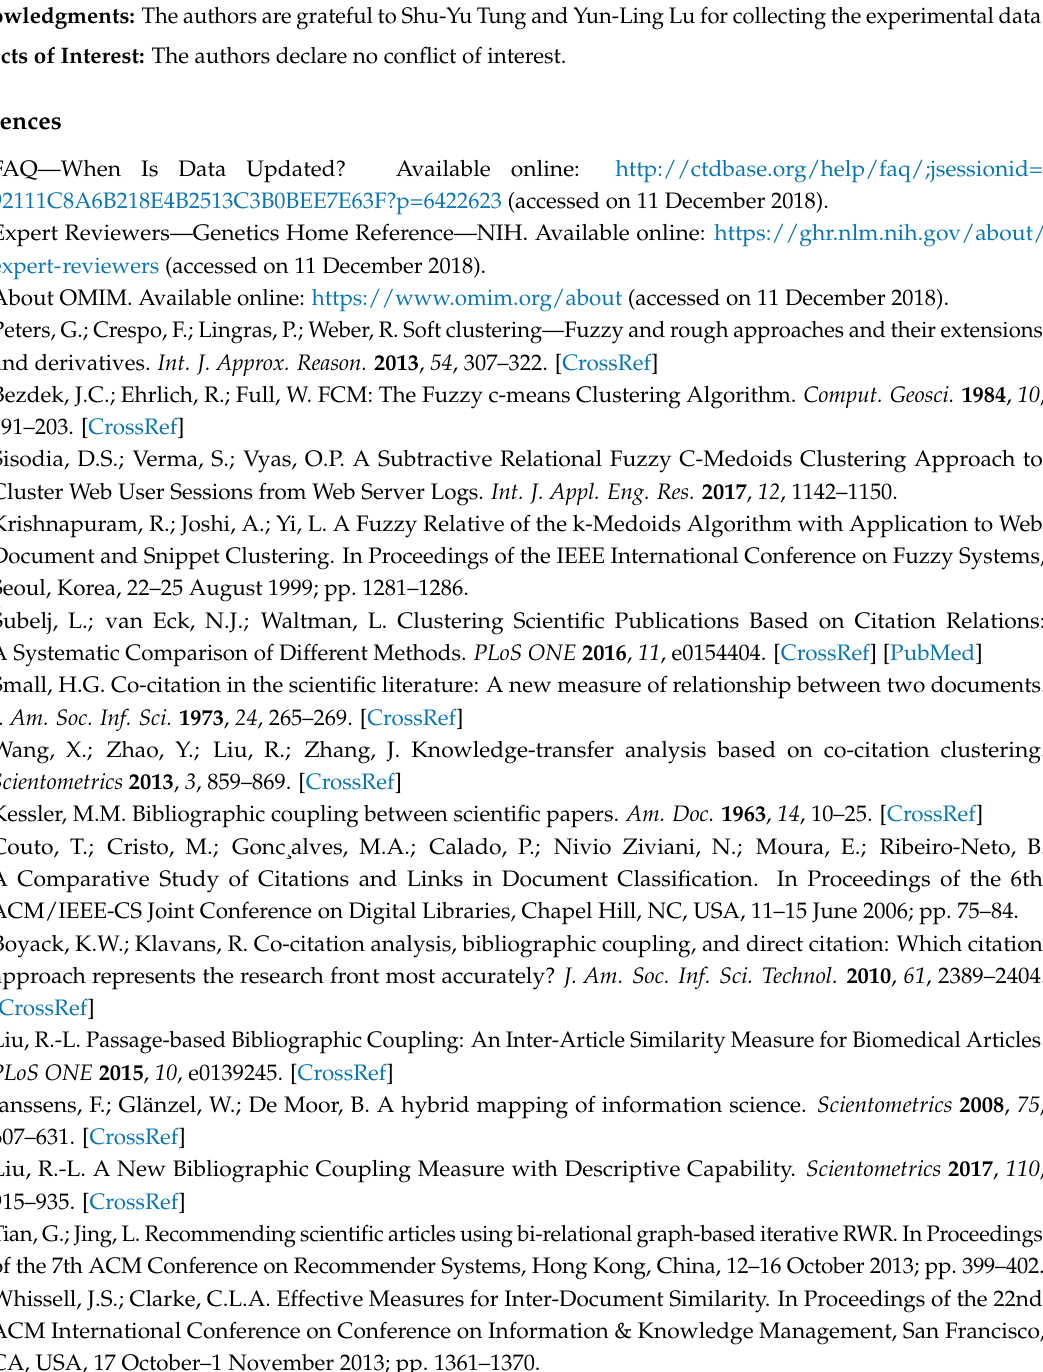
s1, Table S1: Gold standard clusters based on chemical-gene associations; Table S2: Gold standard clusters based on chemical-disease associations; and Table S3: Gold standard clusters based on gene-disease associations. Each row in the tables provides information about a gold standard cluster (i.e., an association curated by CTD experts): first entity, second entity, and IDs of articles that belong to the cluster. Each article has two IDs: